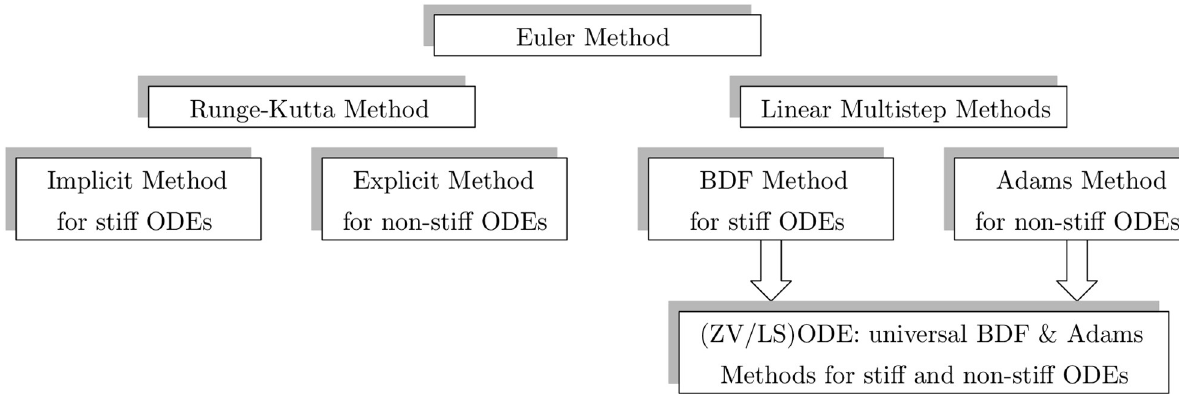
Fig 1. A general overview of the ODE solver and the methods used in the (ZV/LS)ODE implementation.